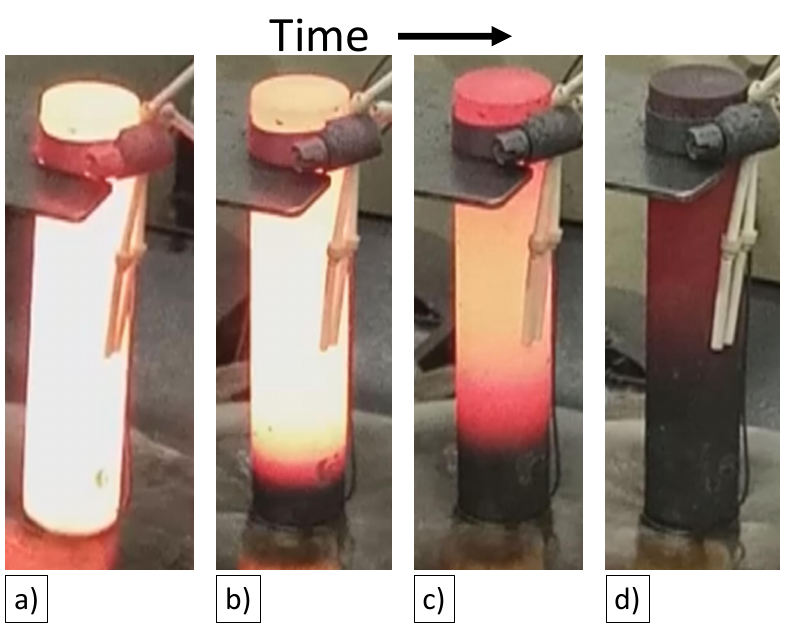
Figure 3. Visible cooling during Jominy end quench test. Thermocouples are applied at the sample. The sample ( a ) directly after water contact (